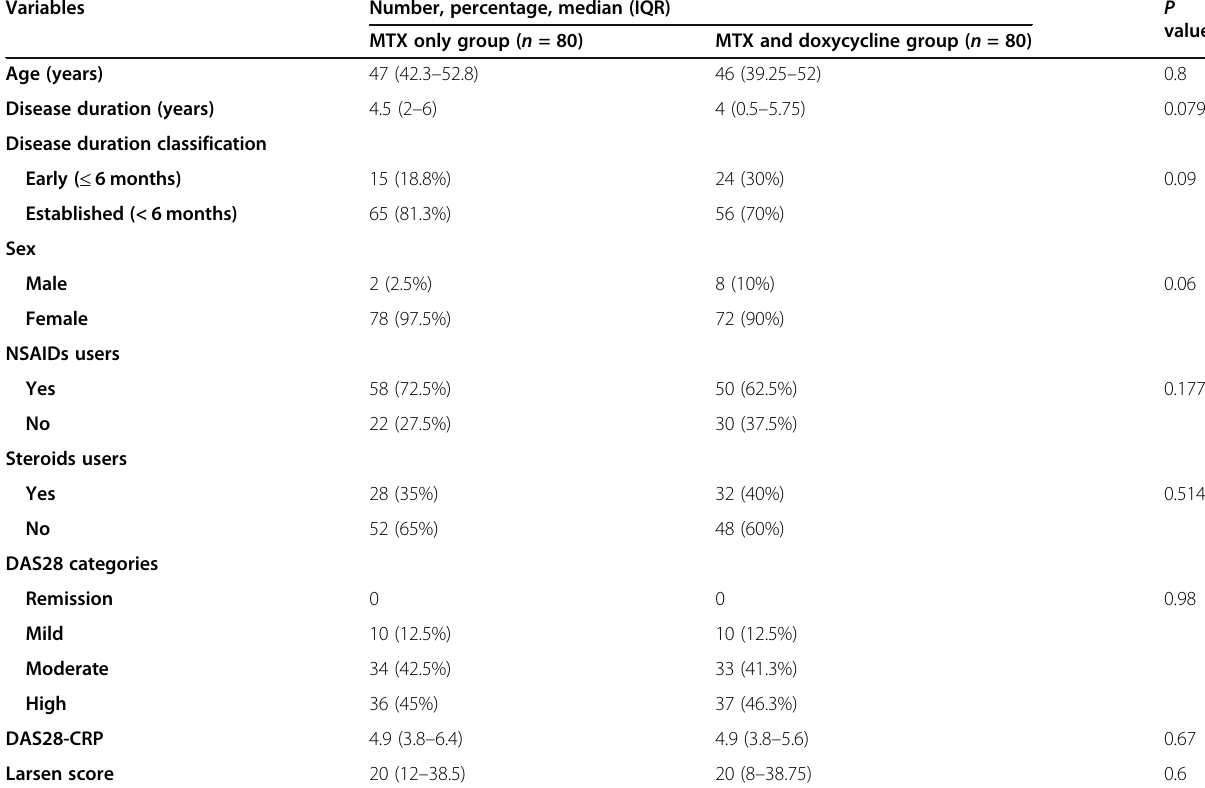
Table 3 Demographic data and radiological results of the two study groups before treatment Variables